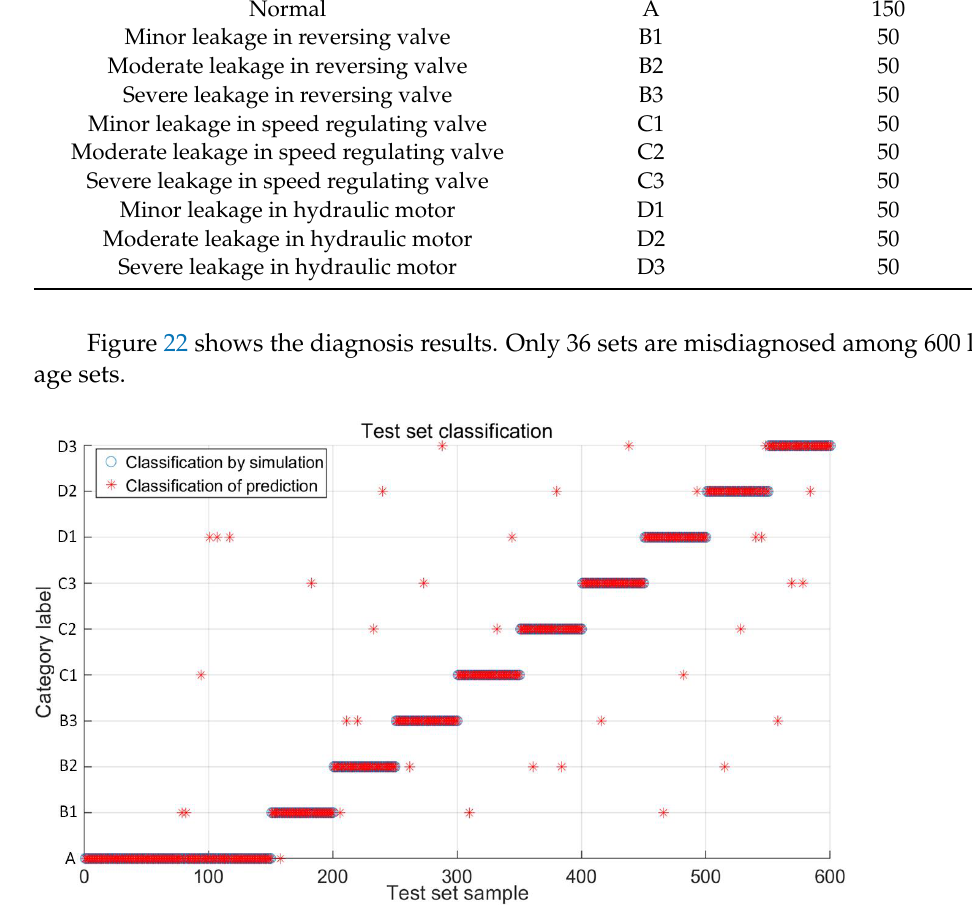
Table 15. Composition of the test set.